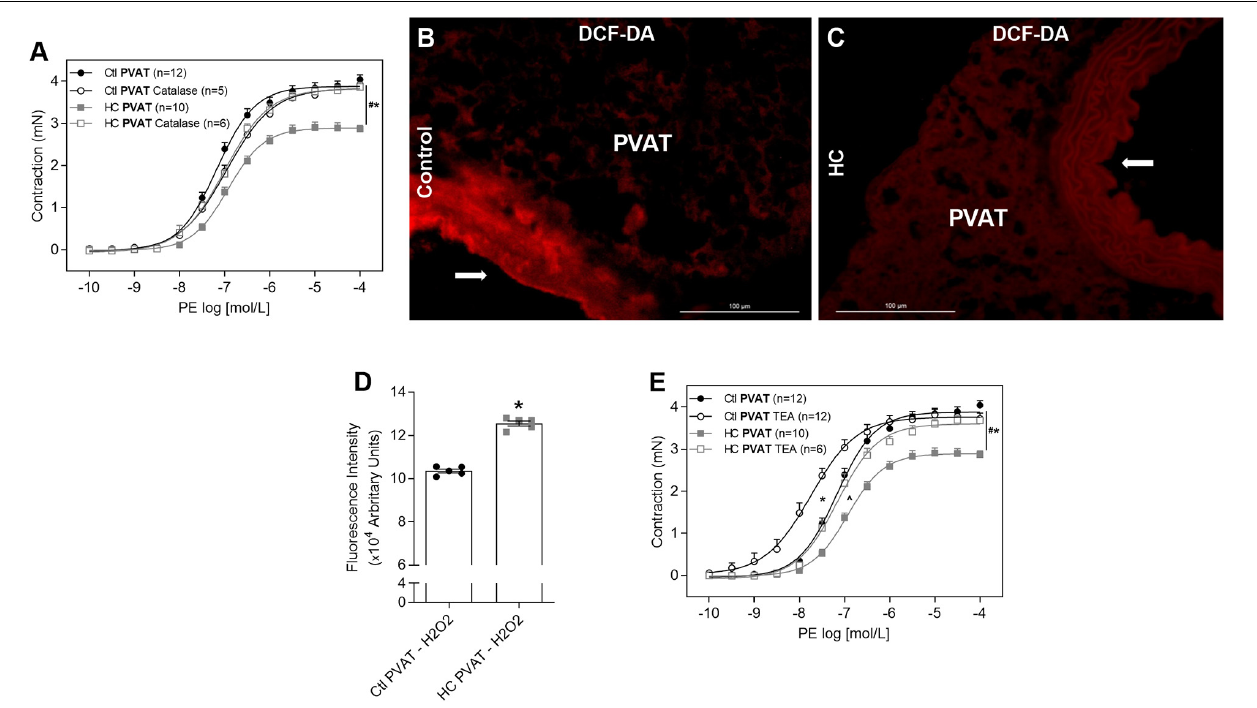
FIGURE 10 | Involvement of H 2 O 2 and potassium channels in the effect of HC diet on PVAT control of vascular tone and evaluation of H 2 O 2 availability. Cumulative concentration-response curves for PE in the presence of PVAT in aortas of control and HC groups previously incubated or not with (A) catalase or (E) TEA. Values represent mean ± SEM. The total number of animals required to carry out the experiments in each group ( n ) is presented in parentheses in the graphs. Statistical significance was determined using two-way ANOVA followed by Holm–Sidak’s post hoc test. * p < 0.05 vs. control PVAT; # p < 0.05 vs. HC PVAT; ∧ p < 0.05 vs. control PVAT TEA represent the differences in the Emax and pD 2 values. Representative sections of basal H 2 O 2 levels in the PVAT of (B) control and (C) HC groups exposed to DCF-DA probe. Arrows indicate the location of the endothelial layer of blood vessels. Scale bars indicate 100 µ m. (D) Quantification of H 2 O 2 production in the PVAT was expressed as fluorescence intensity in graphical bars with mean ± SEM. The total number of animals required to carry out the experiments in each group ( n ) is presented in the dispersion points in the graphs. Statistical significance was determined using Student’s t -test. * p < 0.05 vs.